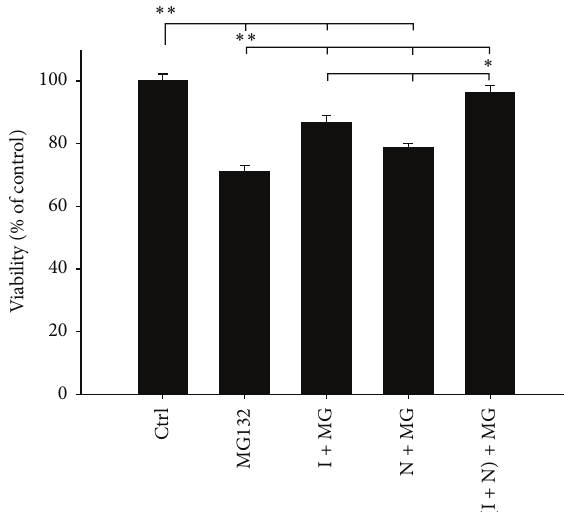
Figure 1: Pretreatment with IGF-1 and NAC increases cell viability after MG132 treatment. Cells were pretreated with vehicle (DMSO), IGF-1 (I), NAC (N), or both (I + N) for 18h followed by the addition of MG132 (MG) (5 𝜇 M) for 24 h. Cell viability was determined by MTT assay as described in the Materials and Methods. The results are expressed as percentage means ± SEM of control and are representativeofthreeindependentexperimentswithfivereplicates. Level of significance is denoted as ∗ 𝑝 ≤ 0.05 and ∗∗ 𝑝 ≤ 0.005